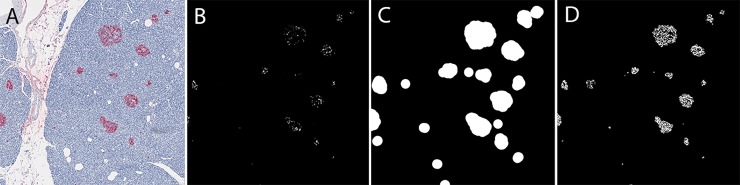
Representative example of the different steps used for selecting Fast Red-stained areas.A: Original image (slide 3160). B: Preselection of high-level red pixels. C: Definition of the regions of interest by circles of 50-pixel radius around each preselected pixel. D: The final output, as obtained by further selecting low-level red pixels in the regions of interest.